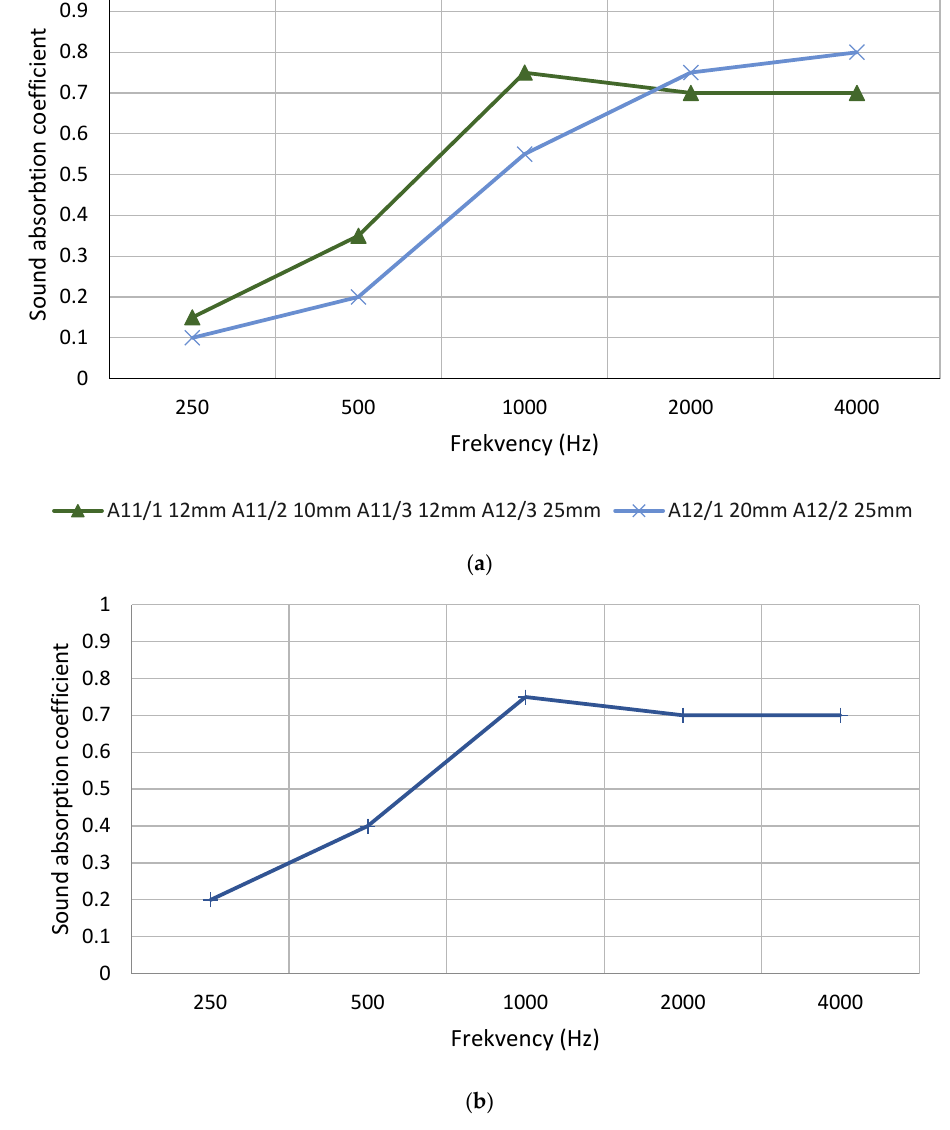
Figure 6. Sound absorption of composite materials without additives: ( a ) A1; ( b ) A2. The created material samples A1 and A2, 22.7 mm and 23.3 mm thick, were compared with the previously studied [21] materials MOC1, MOC2, MOC3, FHL, and MPC. The